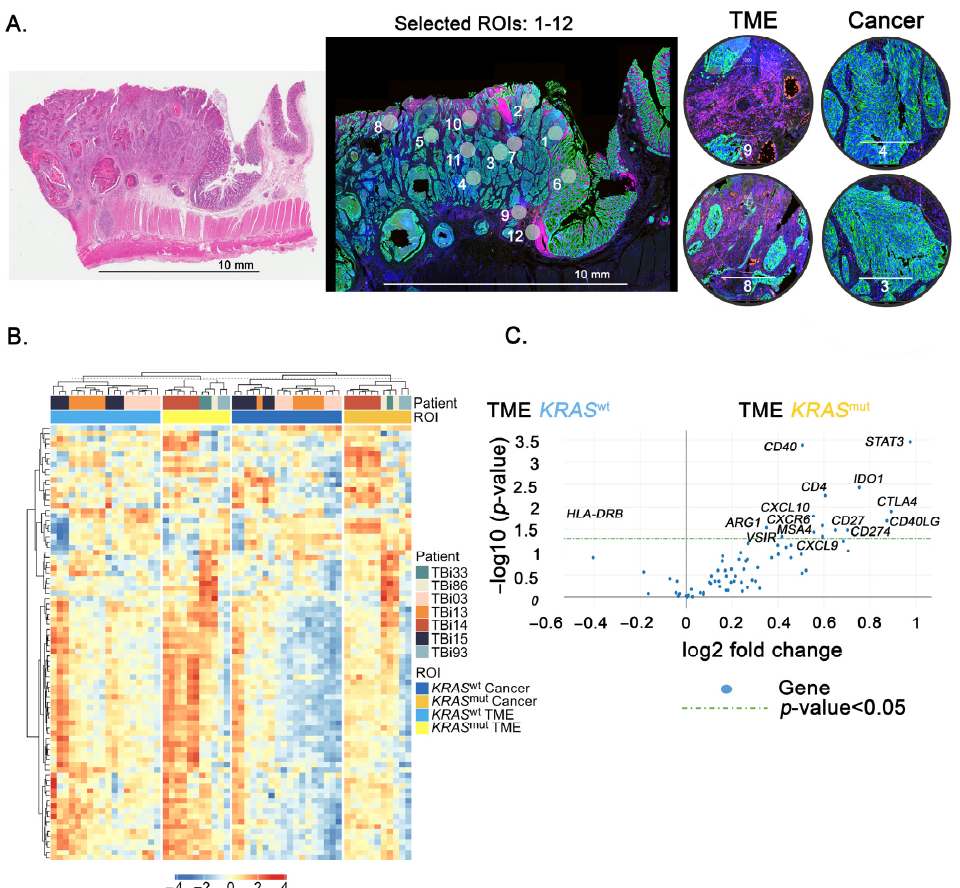
Figure 3. Differential gene expression in TME or cancer regions of patients with CRC KRAS mut or KRAS wt from DSP analysis. ( A ) Representative images of the TBI03 CRC sample stained by hematoxylin and eosin (H&E) ( left ) and immunofluorescence with selected ROIs: 1-12 ( middle ), cancer or TME ROIs ( right ). Representative of ROIs in all patients are shown with tricolor fluorescence labeling (blue: SYTO13; green: Pan-CK; red: CD45 with scale bar 500 μ M. ( B ) Heatmap for 84 DEGs (rows) from the GeoMx immune pathway panel are clustered by TME or cancer (column) in KRAS- mut (yellow) and KRAS wt (blue). Blue to red denotes gene expression, with blue implying low gene expression and red implying high gene expression. ( C ) Volcano plot of 84 genes comparing the dif- ferential gene expression of TME region between KRAS mut and KRAS wt . The x -axis is the log 2 fold change of gene expression between KRAS mut and KRAS wt . The y -axis is the − log 10 p value results. Genes of interest have been annotated within the plot. The blue dots above the green line are genes that are statistically significant upregulation in KRAS mut and KRAS wt .